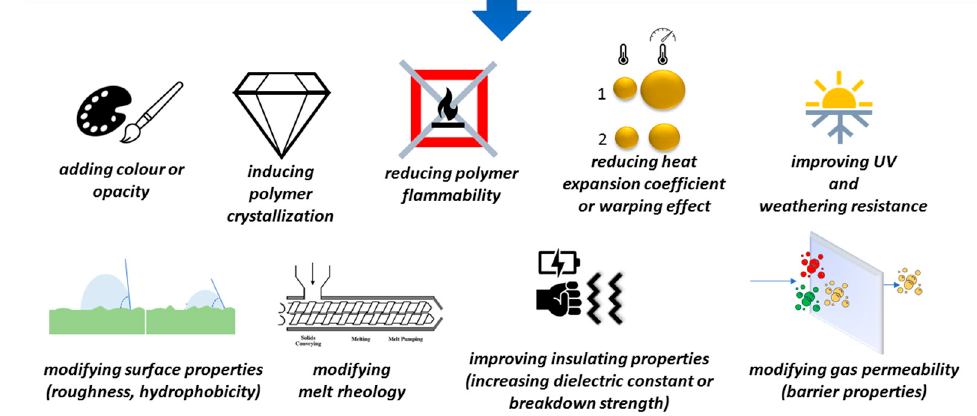
Figure 4. Different functions of fillers in polymer composites.